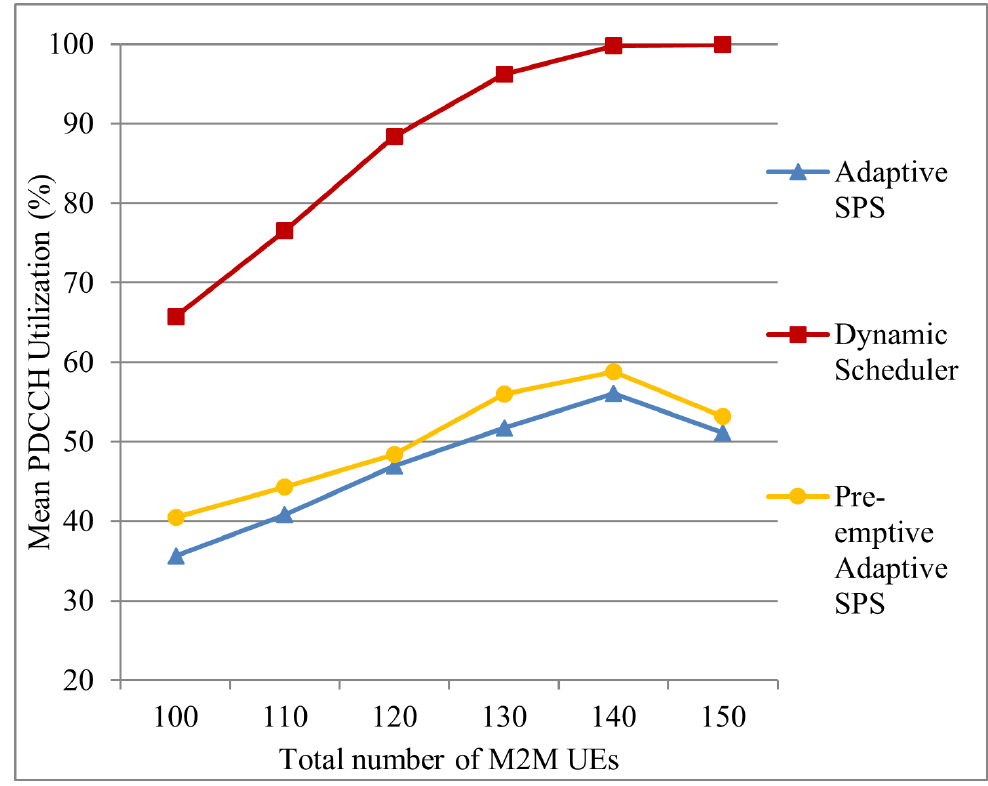
Figure 18. Mean control channel utilization with increasing number of